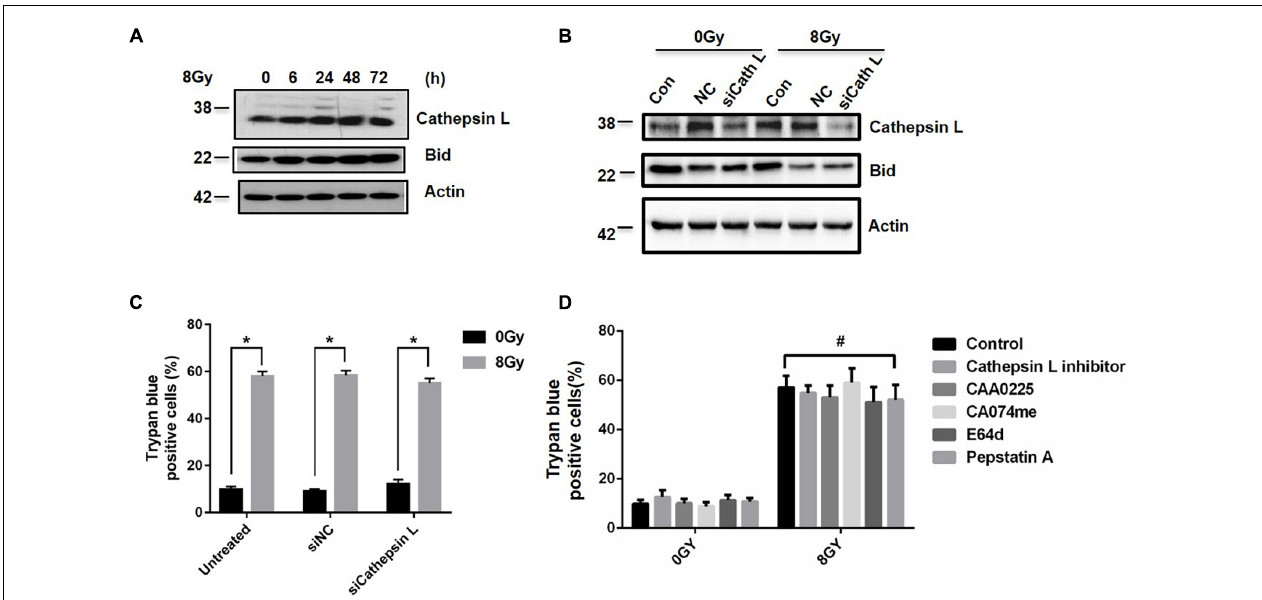
FIGURE 4 | Inhibition of Cathepsin L fails to block radiation-induced cell death. Cathepsin L expression was analyzed by western blot in MDA-MB-231 cells at 6, 24, 48, 72 h after 8 Gy radiation (A) . After the knockdown of Cathepsin L by siRNAs, Cathepsin L and Bid expressions were determined after 8 Gy radiation (B) . Cells were untransfected or transfected with control siRNA (siNC) and siRNA against Cathepsin L (siCathepsin L) for 48 h before 8 Gy radiation, then cell death was determined (C) . Cells were pretreated with CAA0225 (a Cathepsin L inhibitor, 10 µ g/ml) for 1 h before 8 Gy treatment, cathepsin L and Cleaved-Caspase3 expression were tested (D) . These results were representative of three independent experiments and expressed as means ± SD. P -values were calculated using repeated measure ANOVA with P < 0.05 being considered as statistical significance, * P < 0.05, # P >